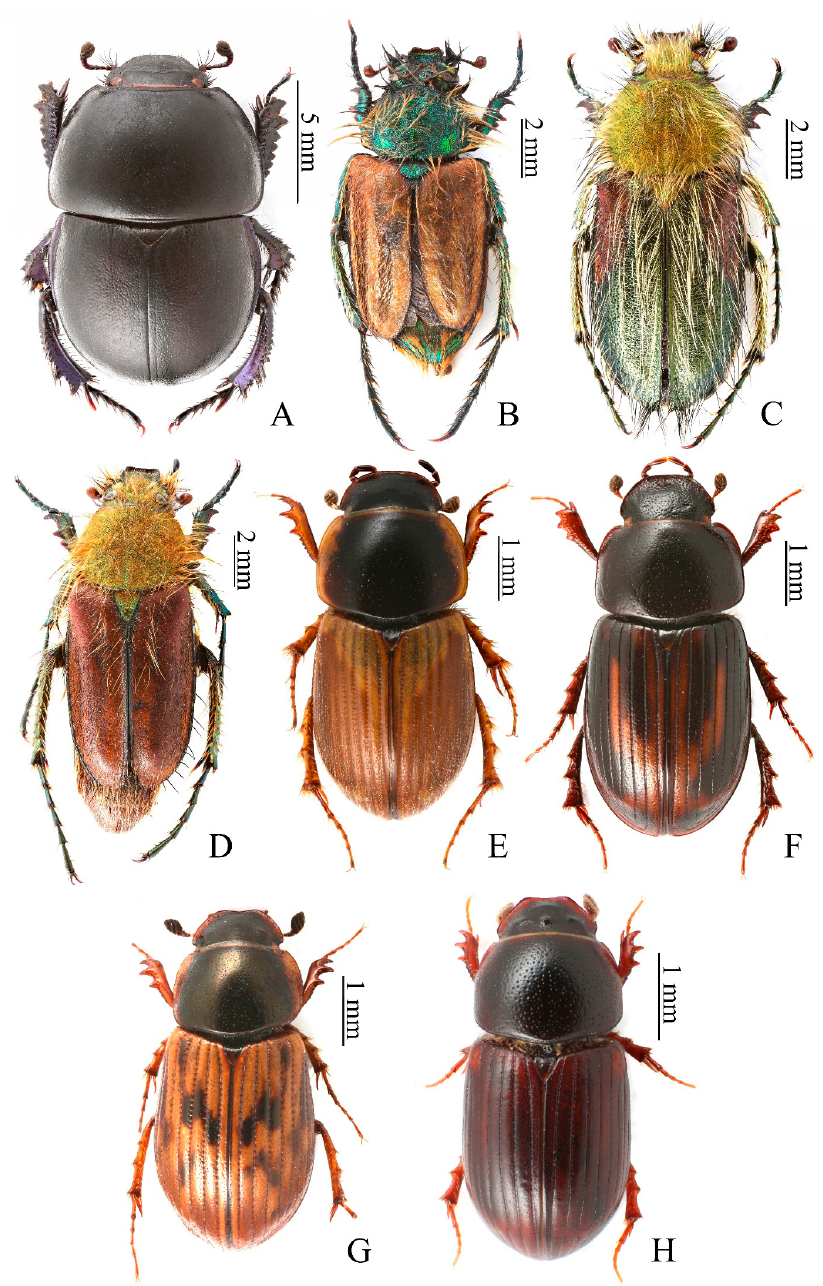
Figure 5. Rare and new species for the fauna of Serbia recorded in the course of this study: ( A )—Jekelius punctulatus (Jekel, 1866), ( B )—*Eulasia pareyssei (Brullé, 1832), ( C )—*Pygopleurus apicalis (Brullé, 1832), ( D )—P. chrysonotus (Brullé, 1832), ( E )—*Melinopterus reyi (Reitter, 1892), ( F )—Neagolius bilimeckii (Seidlitz, 1891), ( G )—*Nimbus johnsoni (Baraud, 1976), ( H )—*Planolinoides borealis (Gyllenhal, 1827) (Photos: Ł ukasz Minkina).